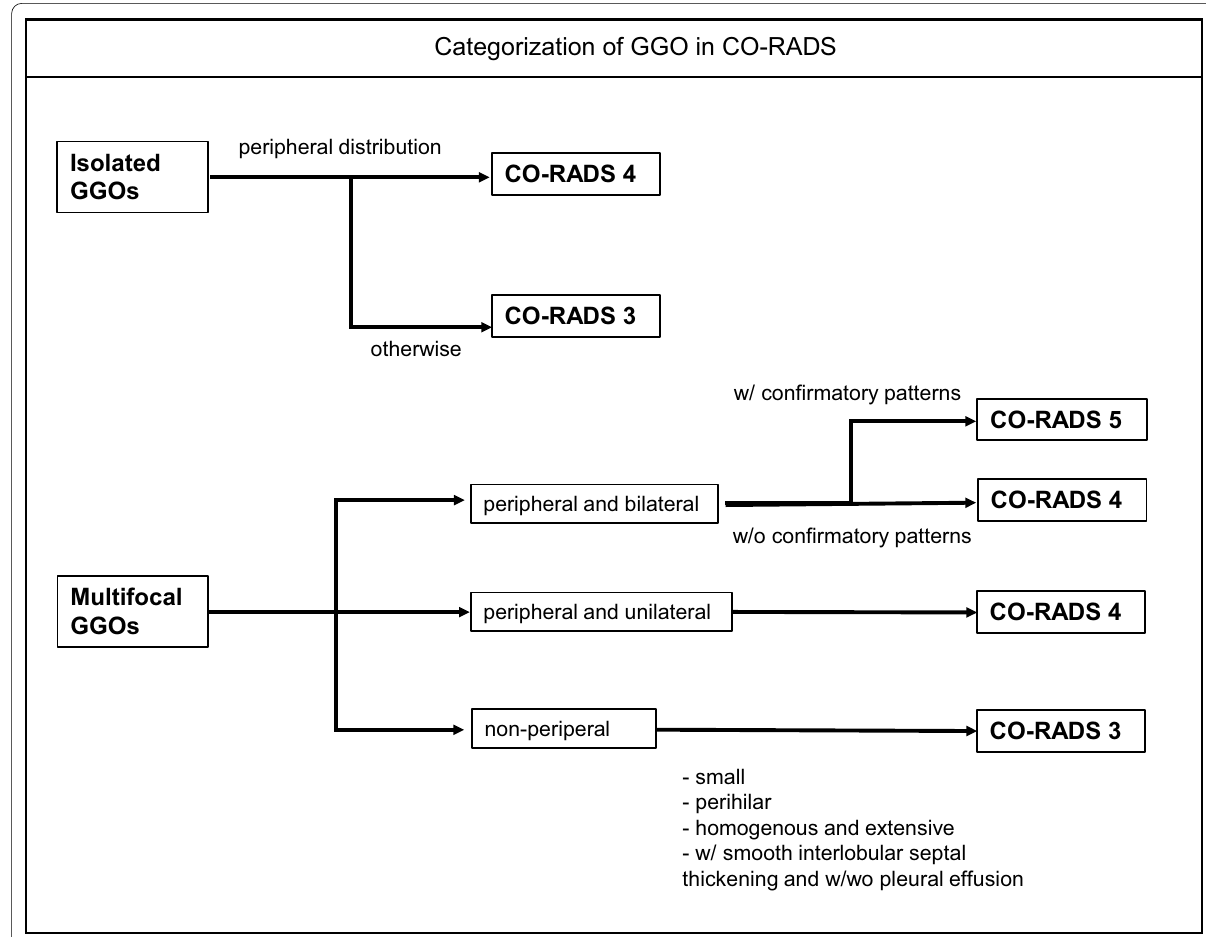
Fig. 3 Flow chart illustrating the categorization of ground-glass opacity in